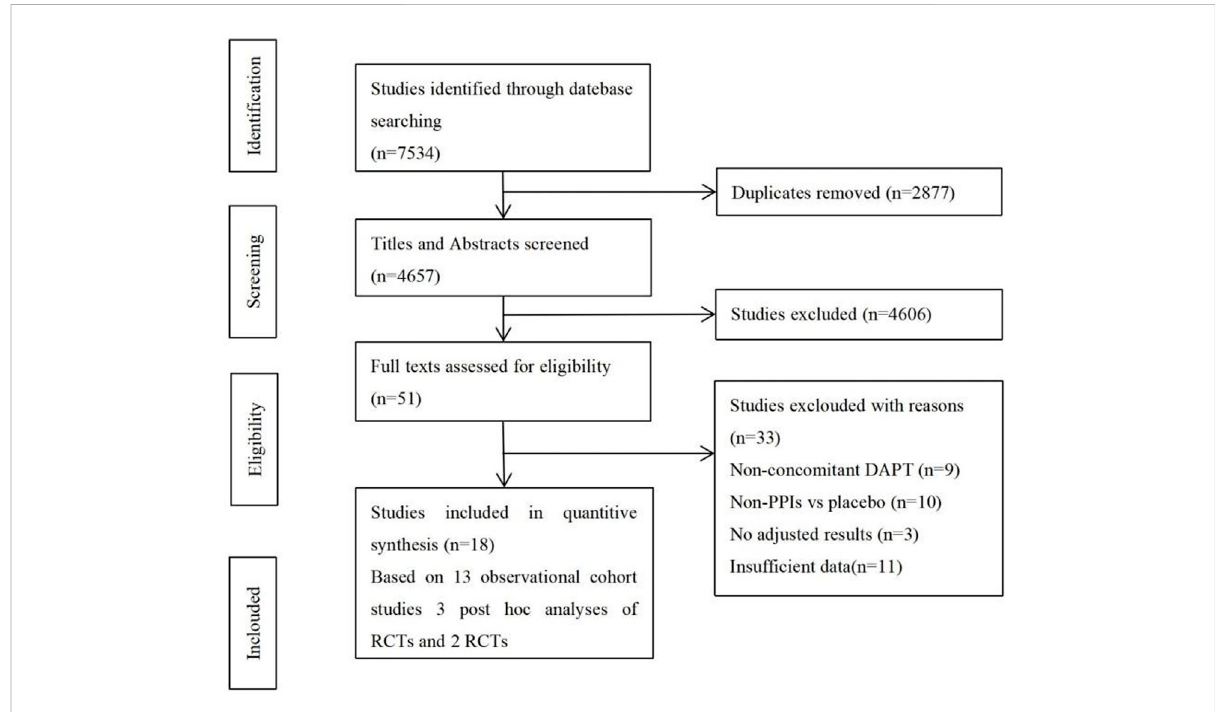
FIGURE 1 Flowchart of study